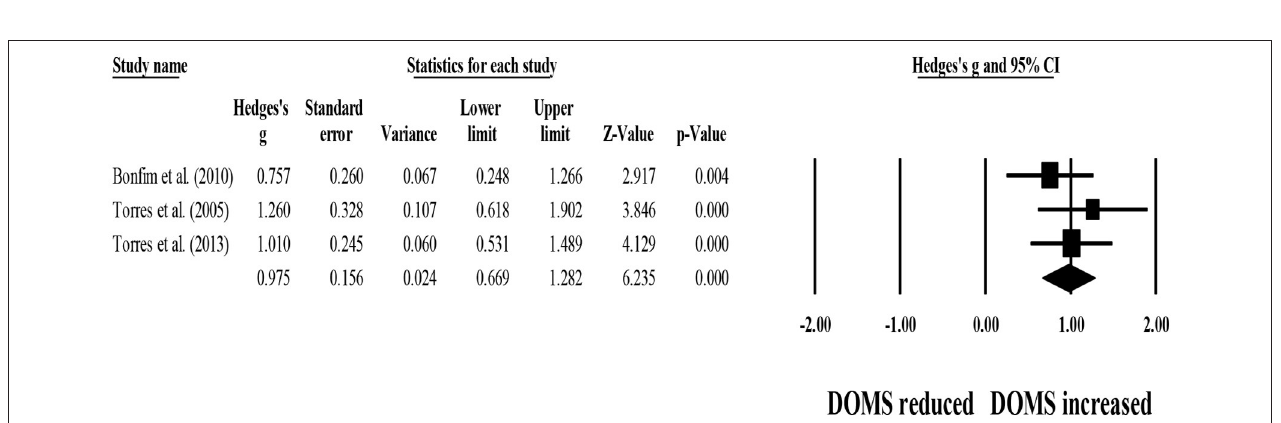
FIGURE 11 | Forest plot of changes in 48-h post-exercise delayed onset of muscle soreness (DOMS) after participating in post-exercise stretching protocols compared to control conditions (i.e., passive recovery). Values shown are effect sizes (Hedges’s g) with 95% confidence intervals (CI). The size of the plotted squares reflects the statistical weight of each study. The black diamond reflects the overall result.